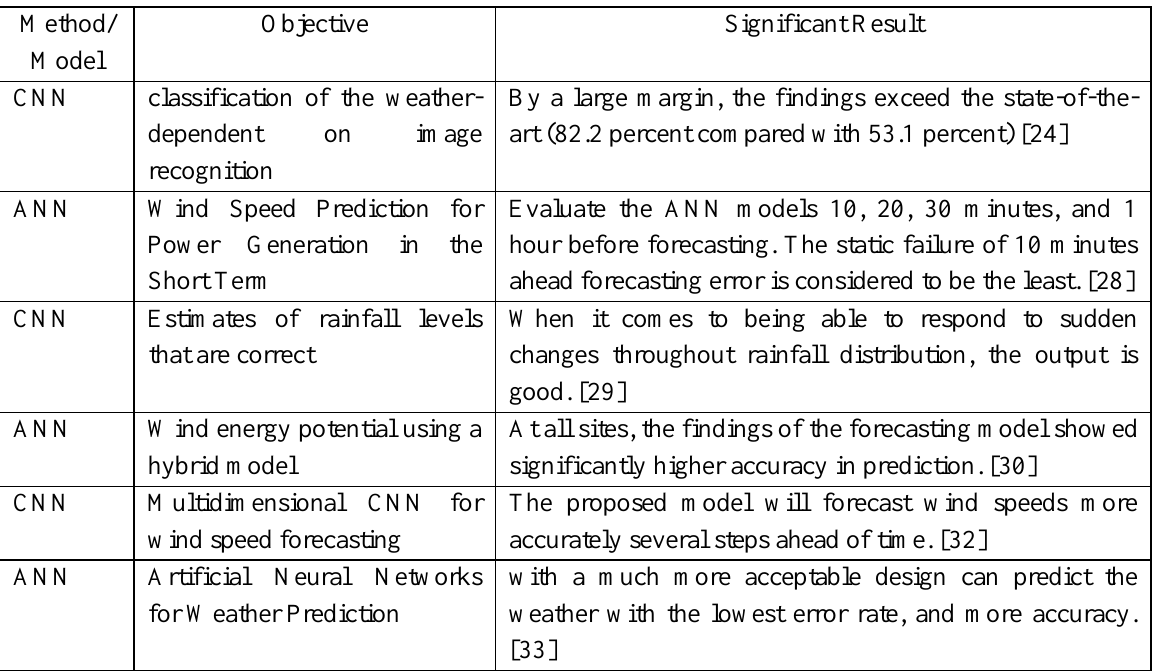
Table 1 . T he outcomes of a number of weather forecasting applications that have implemented ANN algorithms and CNN